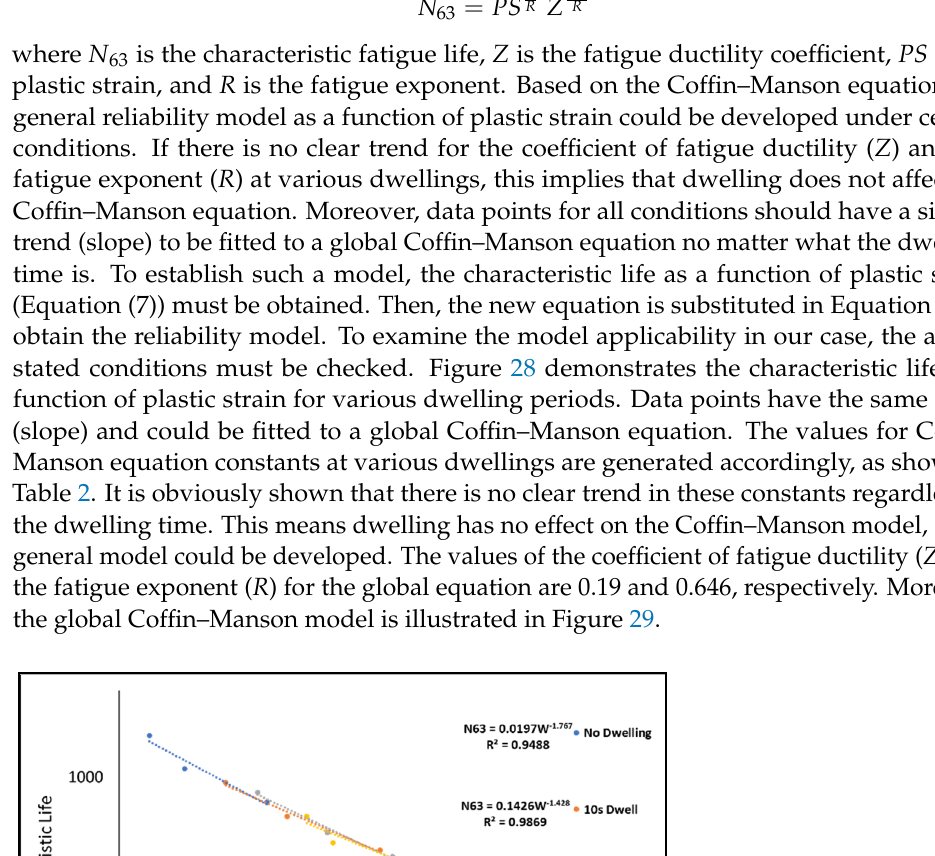
Figure 27. D-value as a function of stress amplitude.